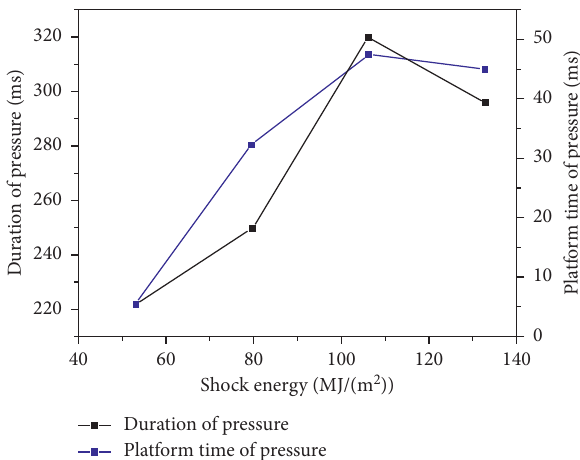
Figure 20: Comparison of platform time and pressure duration for the Al/PTFE/W energetic jets for different target